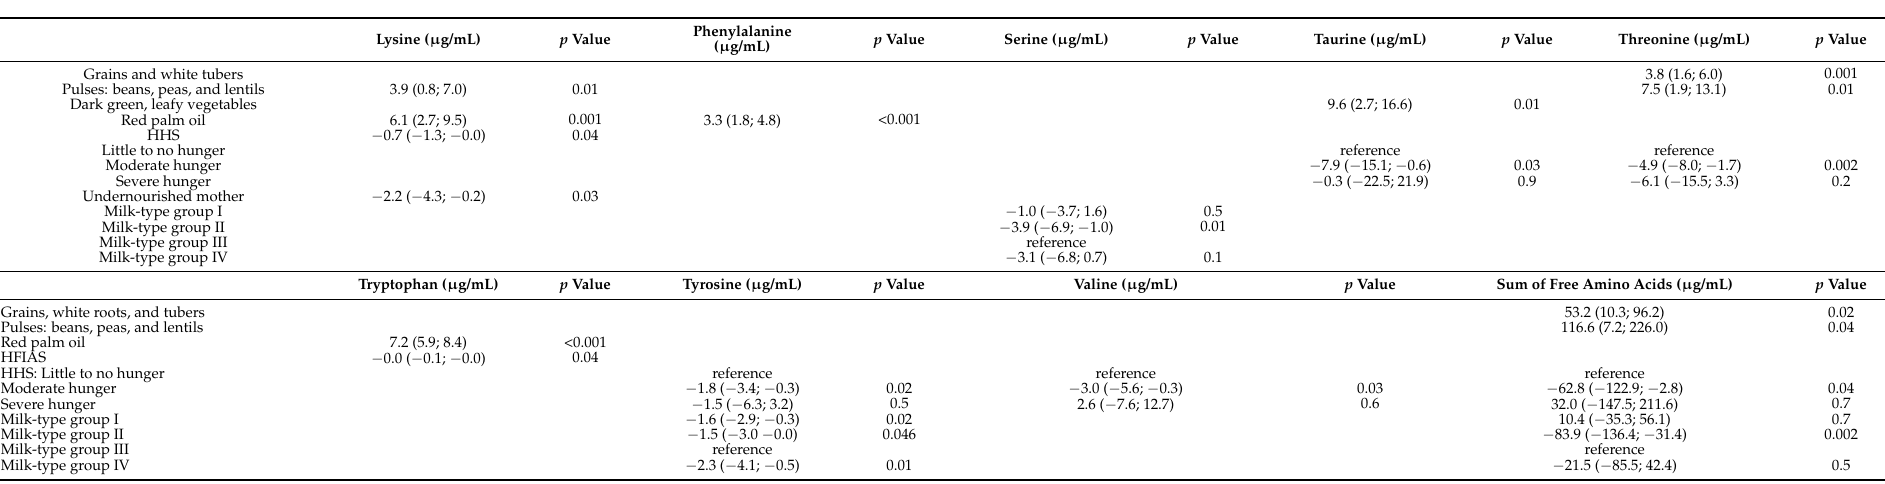
Table 10. Multilevel models of the dietary determinants of human milk free amino acids during the first 6 months of life